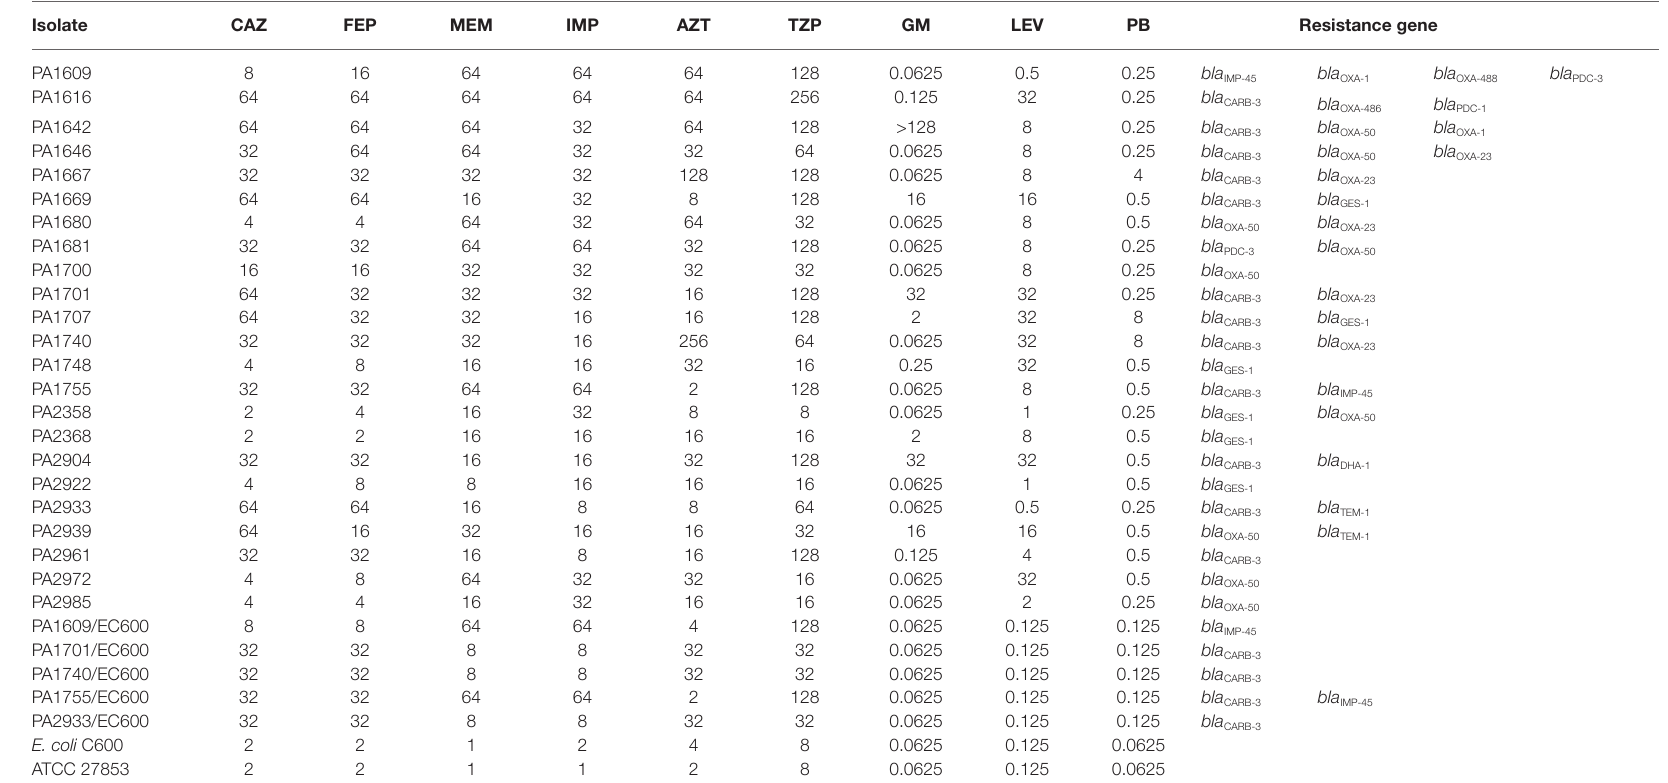
TABLE 3 | Antimicrobial susceptibility and β -lactam resistance gene distribution of the 23 β -lactamase gene-positive P. aeruginosa isolates.